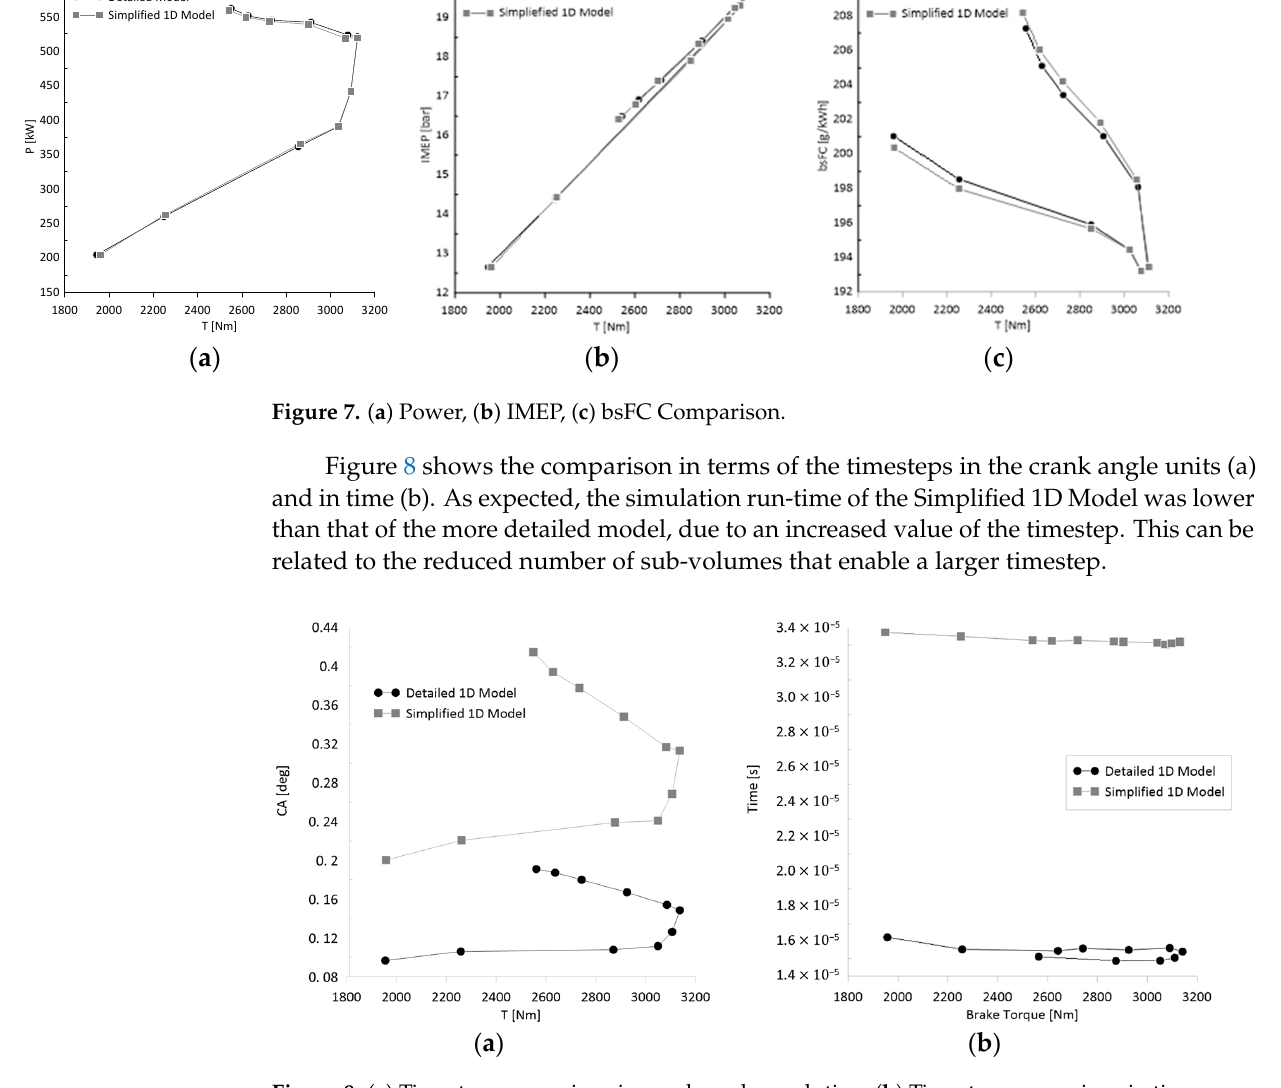
Figure 8. ( a ) Timestep comparison in crank angle resolution; ( b ) Timestep comparison in time.